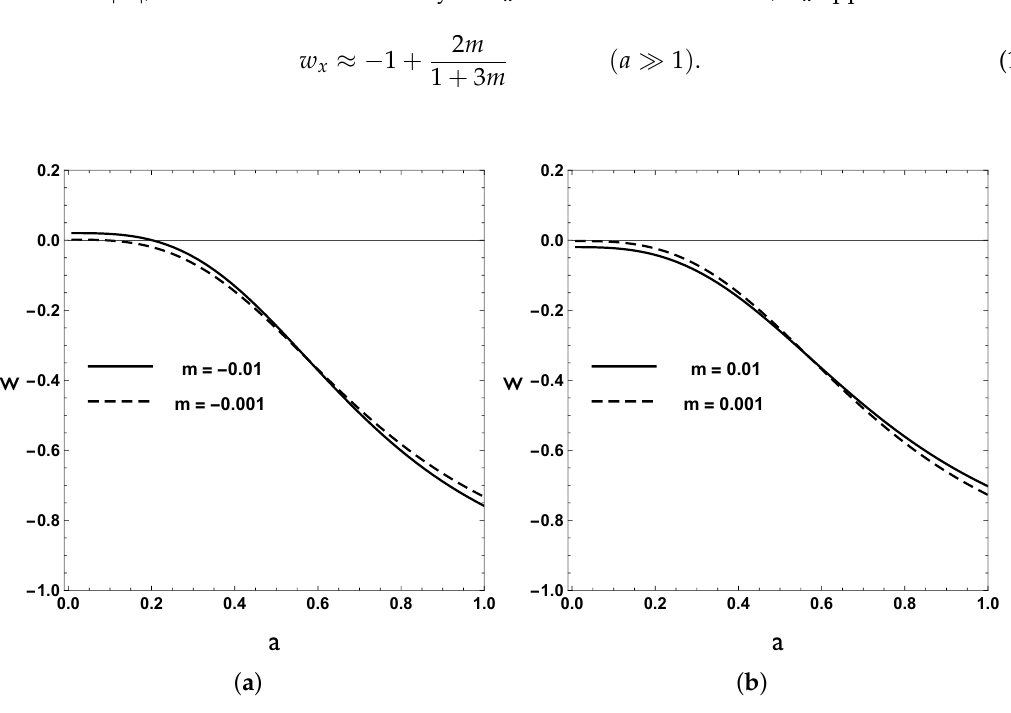
Figure 2. Total EoS parameter w = p